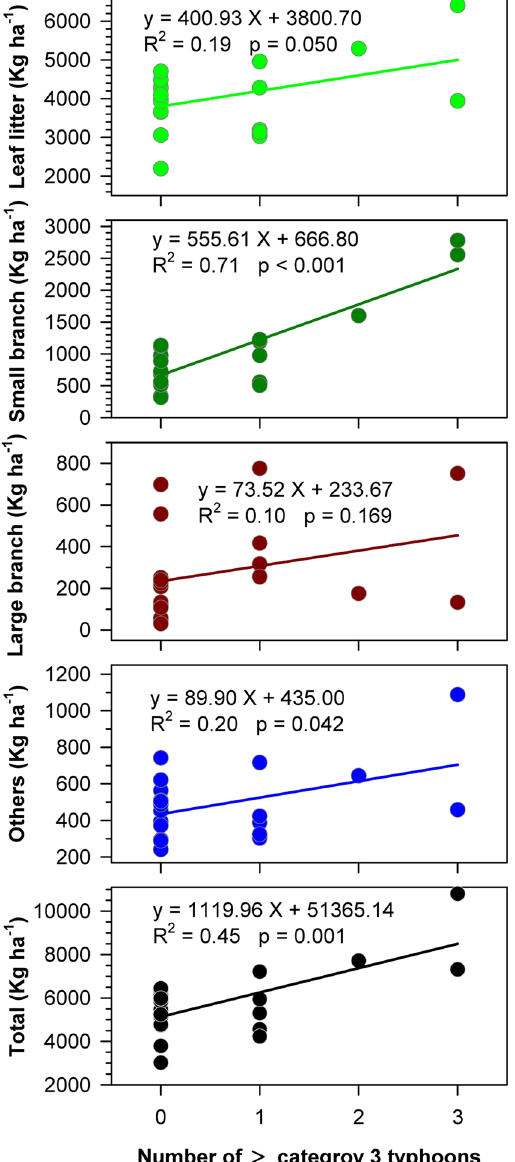
Figure 4. The relationships between annual litterfall components and the number of ≥ category 3